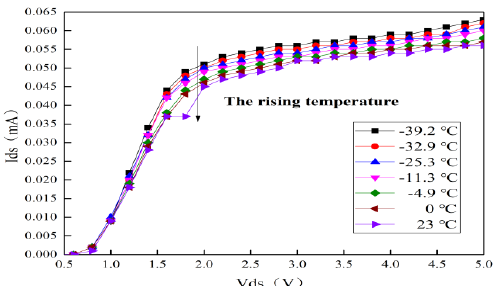
Figure 6. Measured curves of output characteristic with typical alpine temperatures.